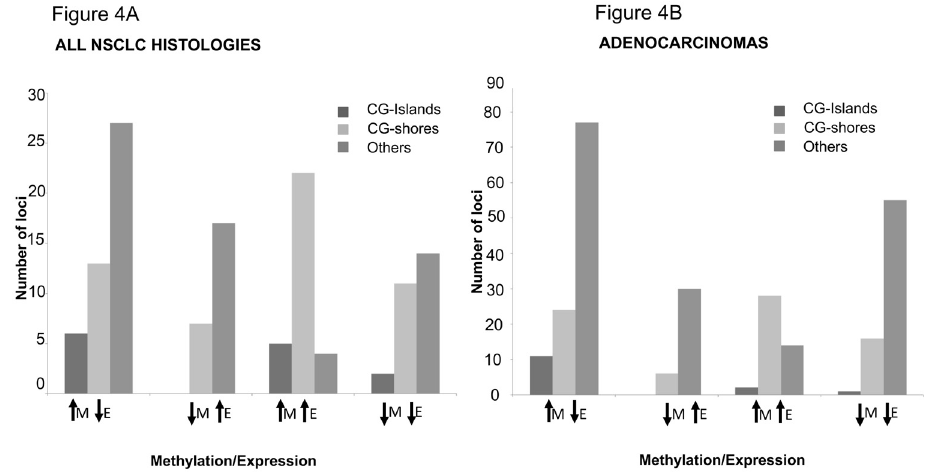
Fig 4. Methylation vs Expression in Promoter regions. Analysis of DM loci within promoter regions and their overlap with differential gene expression. (Left panel A) All 21 pairs (all NSCLC histologies), overall differences do vary by PR genomic location (CGI, CGS, other), ChiSquare p = 3.32E-4. (Right panel B) Within the set of adenocarcinomas overall differences do vary by PR genomic location (CGI, CGS, other), ChiSquare p = 1.10E-7. Majority of DM promoter loci are associated with hypermethylation when the DM loci are within CG islands. This effect is more pronounced among adenocarcinomas, where the DM loci in CG islands are mostly associated with downregulation of the gene. KEY: “ M ” = methylation, “ E ” = expression. Upward arrow indicates increase and downward arrow indicates